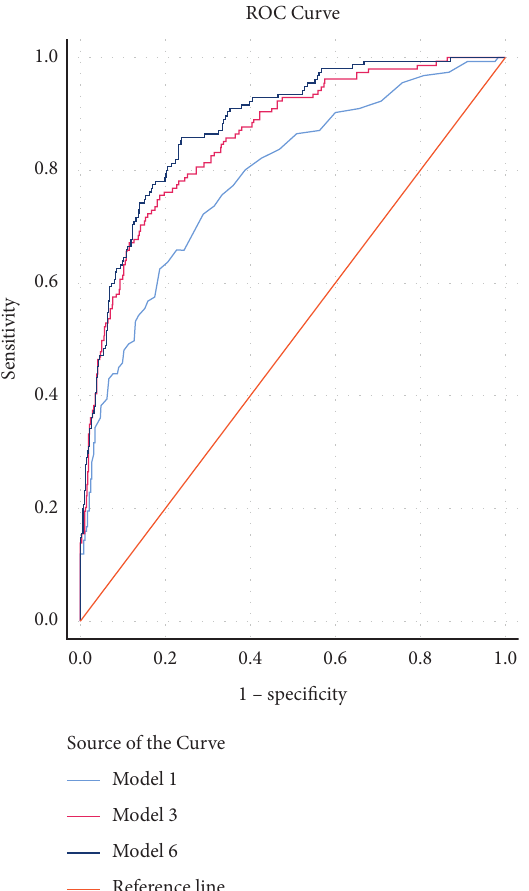
Figure 2: Comparison of the receiver operating characteristic (ROC) curves of different regression models predicting 30-day mortality. Model 1: Lactate. Model 3: lactate, intubation, age. Model 6: lactate, intubation, age, base excess, left ventricular ejection fraction, and systolic blood pressure.